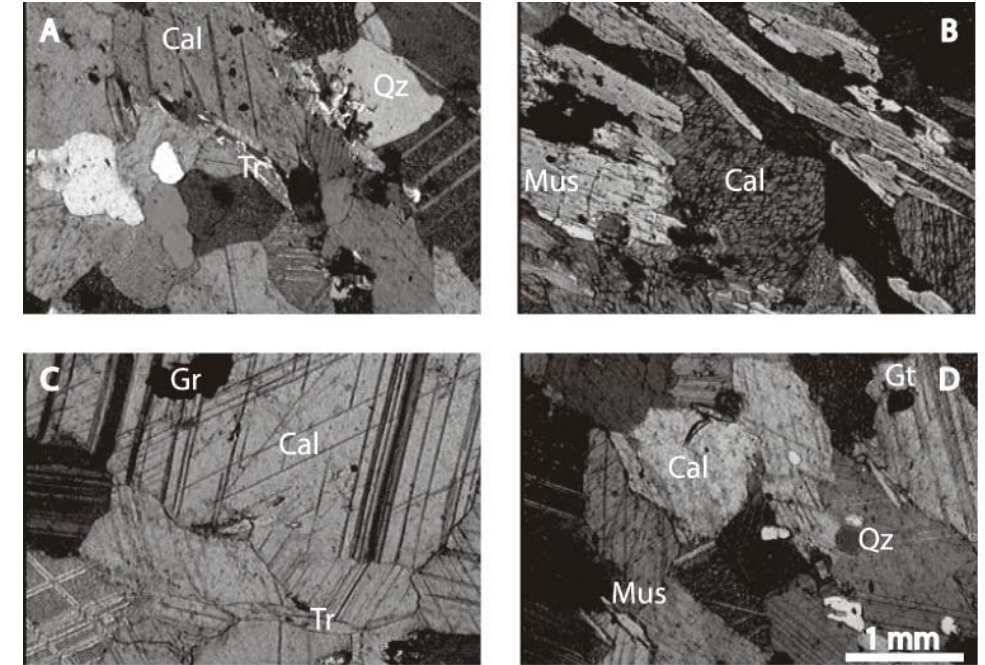
Fig. 3 – Main petrographic characteristics of the SCC marbles. Thin sections from the Pedra de Cal (A), Malutagem (B), Rodiador (C) and Santa Rosa (D) sections. Calcite (Ca), quartz (Qz), tremolite (Tr), garnet (Gt), graphite (Gr), muscovite